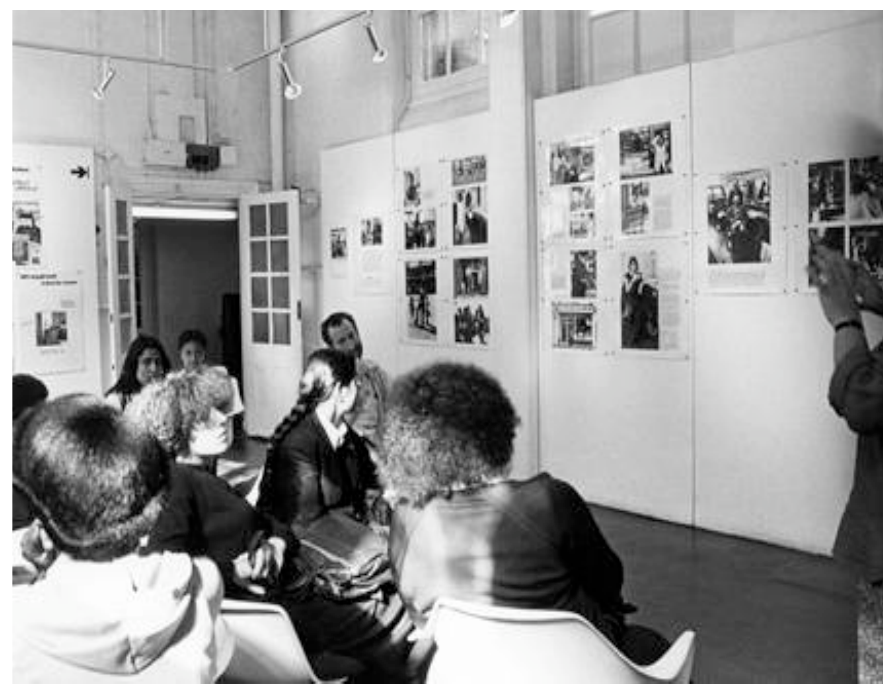
Figure 1: Hackney Flashers 1978 Beyond the Family Album and Other projects Belfast Exposed Archive